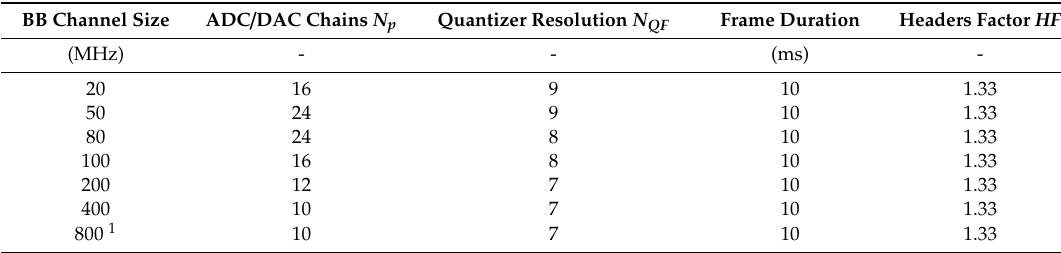
Table 2. Additional parameters of FH / MH radio streams for calculation of bandwidth consumption in the lower Split / Option interfaces